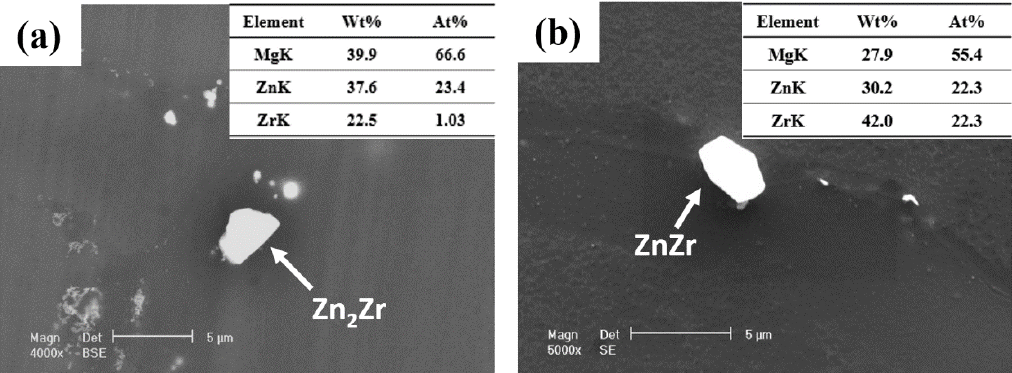
Figure 5. ( a , b ) the SEM image of particle phase at the grain boundary, and corresponding spot spectrum EDS results of bulk-shaped phases at grain boundary.